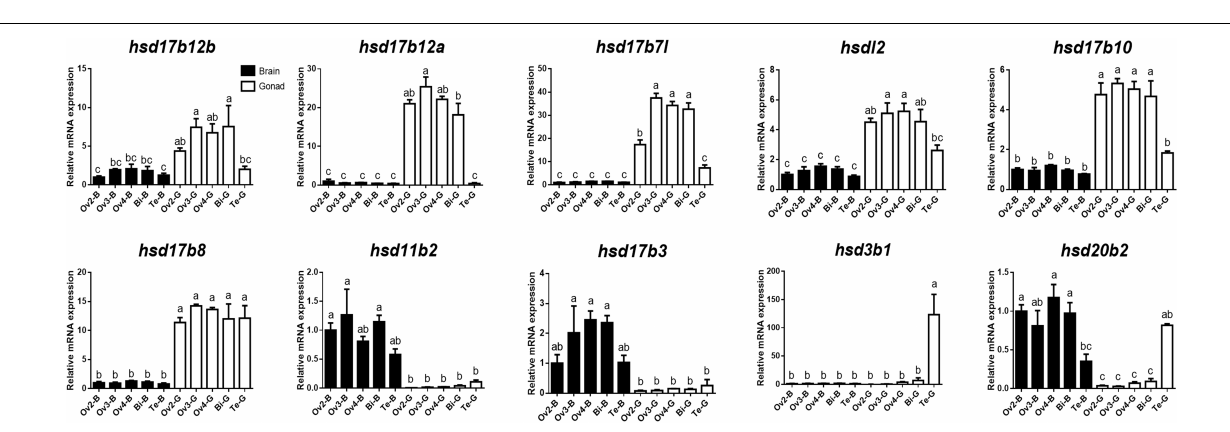
FIGURE 5 | Quantitative RT-PCR examination of 10 β -hsd genes expressions in the brain and gonad during sex reversal of grouper. Values represent the relative mRNA expression in relation to internal control ( β -actin gene). Data were expressed as the mean ± SEM for four replicates. In each panel, different lowercase letters indicate significant differences ( p <